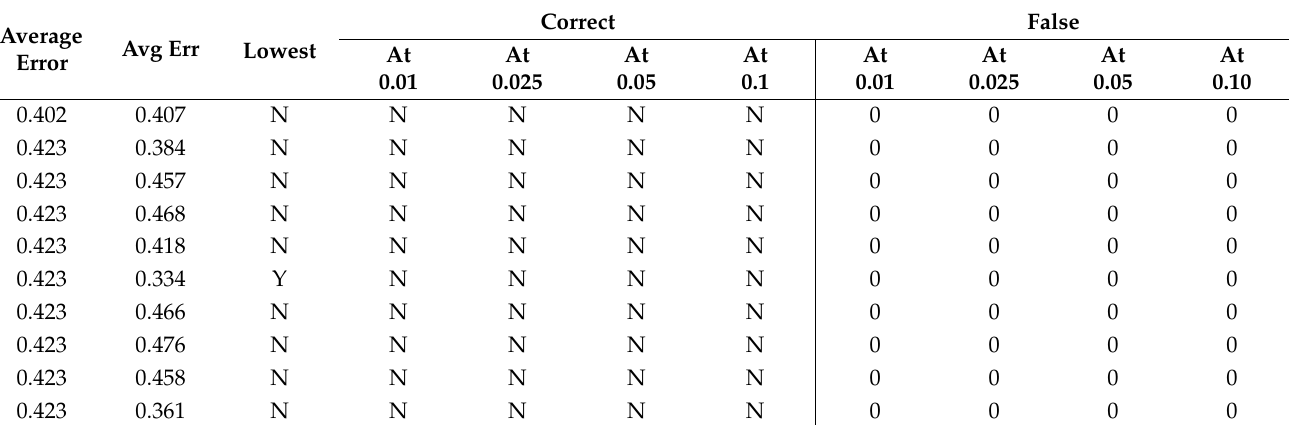
Table 5. Set 2, trials 11–20 data (all 0.5 PR